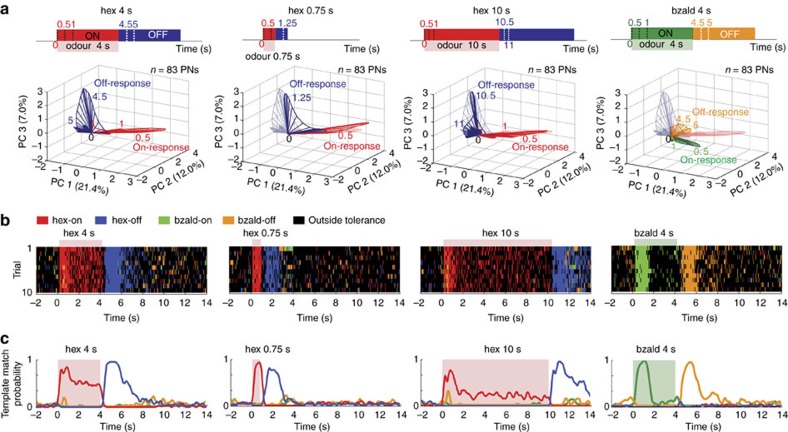
Classification analyses of ensemble neural activity.(a) ON and OFF response trajectories evoked by a 4 s hex 1% puff is compared with the response trajectories elicited by a brief (0.75 s) or a lengthy (10 s) presentation of the same odorant, and against a different odorant (bzald 1% delivered for 4 s). For reference, ON and OFF hex (4 s) trajectories are re-plotted in all panels using a lighter shade of red and blue, respectively. n represents the total PN number. All other notations and information are consistent with neural trajectory plots shown in Fig. 1b–e. (b) Results from a supervised classification analysis (see Methods) are shown. Each row represents a trial and each tick mark corresponds to the class label assigned to the high dimensional neural activity observed in a 50 ms time bin. Each time bin was labelled based on the closest template with which it pattern-matched: hex ON response template—‘red tick mark', hex OFF response template—‘blue tick mark', bzald ON response template—‘green tick mark', bzald OFF response template—‘orange tick mark', and time bins when the ensemble neural activity differed significantly from all hex and bzald response templates (> 63°) were labelled using a ‘black tick mark'. Classification for ten trials are shown for hex presentations of different durations and a 4 s bzald pulse. A leave-one-trial-out validation was followed for classification of hex 4 s and bzald 4 s conditions. The coloured bar on the top indicates stimulus duration. (c) The probabilities of pattern-match with different templates (used in b) are shown as a function of time. The coloured box identifies the time period when the stimulus was presented.